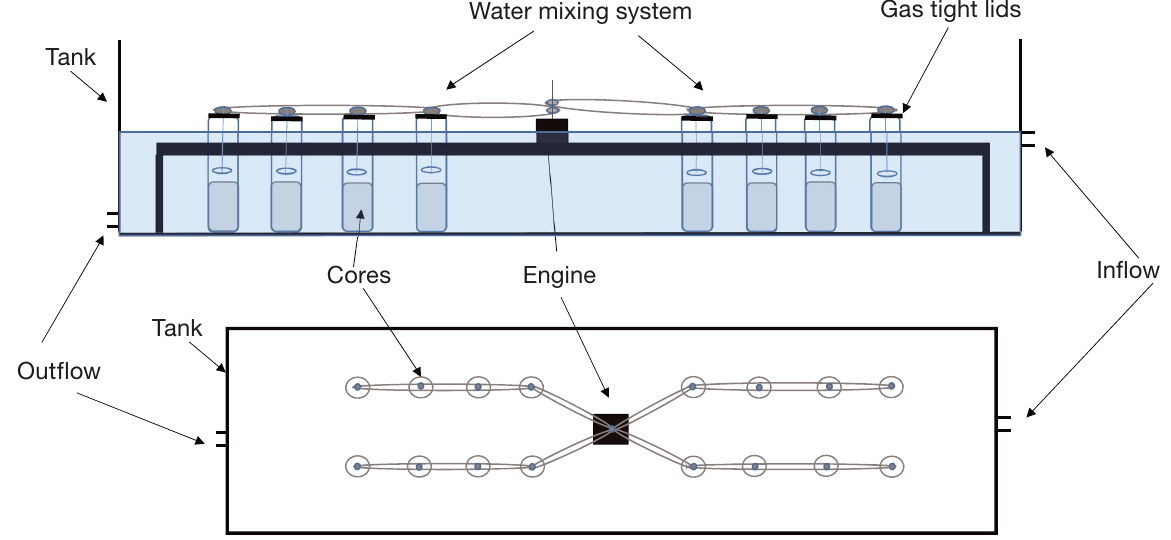
Fig. 1. Schematic illustration of tank and experimental